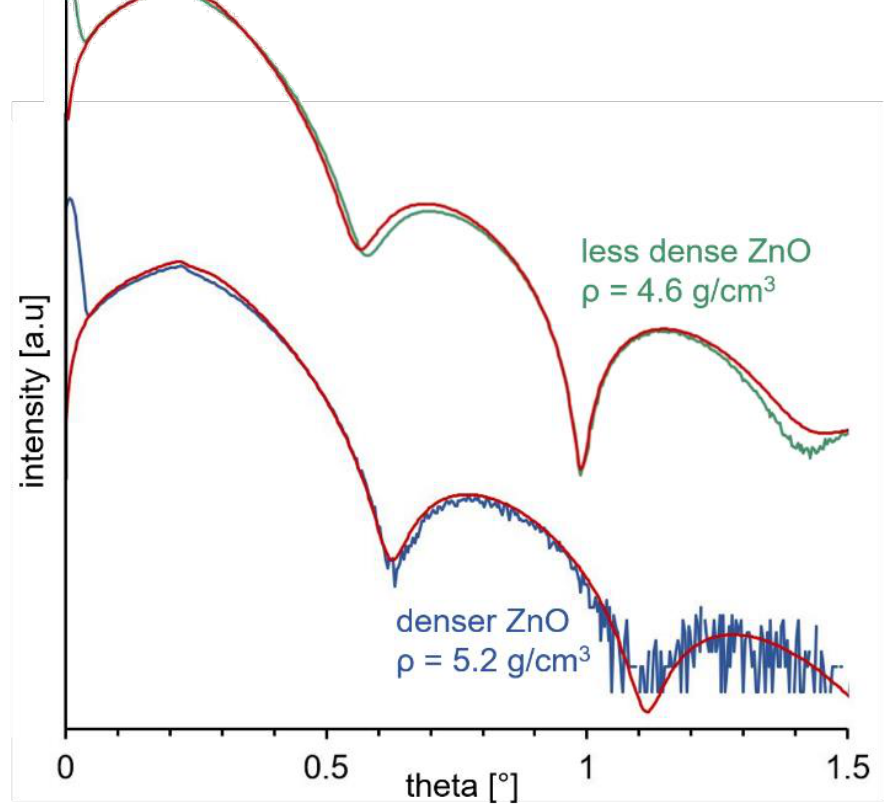
Figure 1. X-ray reflectivity measurements of ZnO thin films deposited for 60 cycles, showing different mass densities. Red lines correspond to fits.